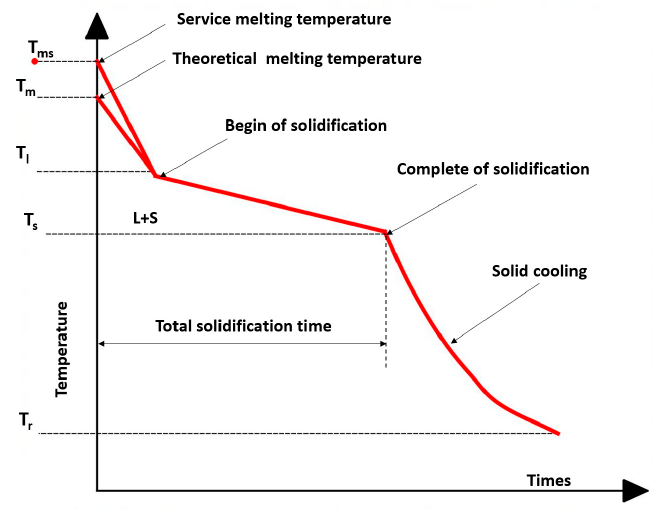
Figure 3. Theoretical solidification curve of the alloy.